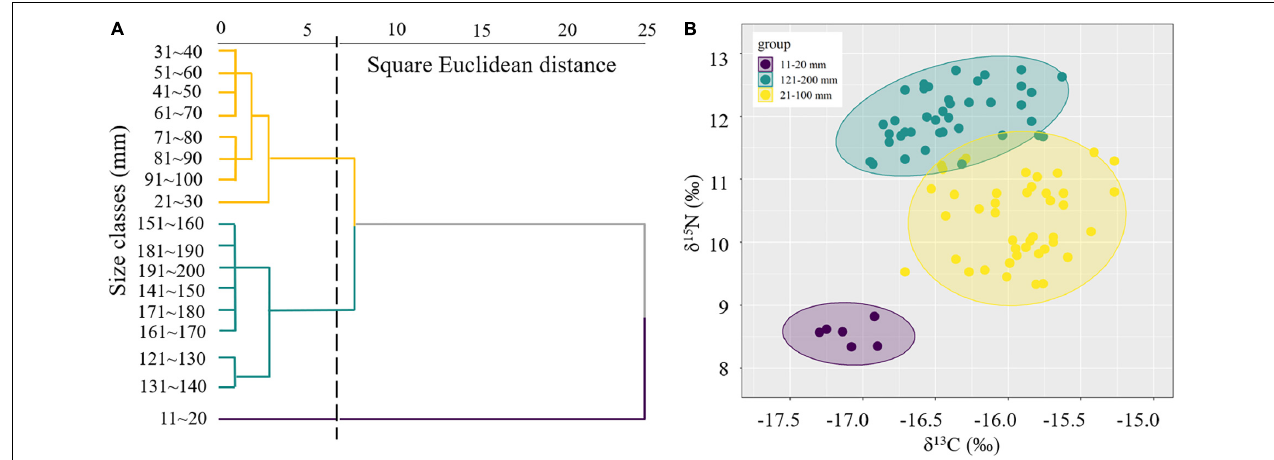
FIGURE 2 | Cluster analysis of the isotopic values with different measurements (A) and size-corrected Bayesian standardized ellipse areas (SEAc) for each group (B) of S. esculenta .